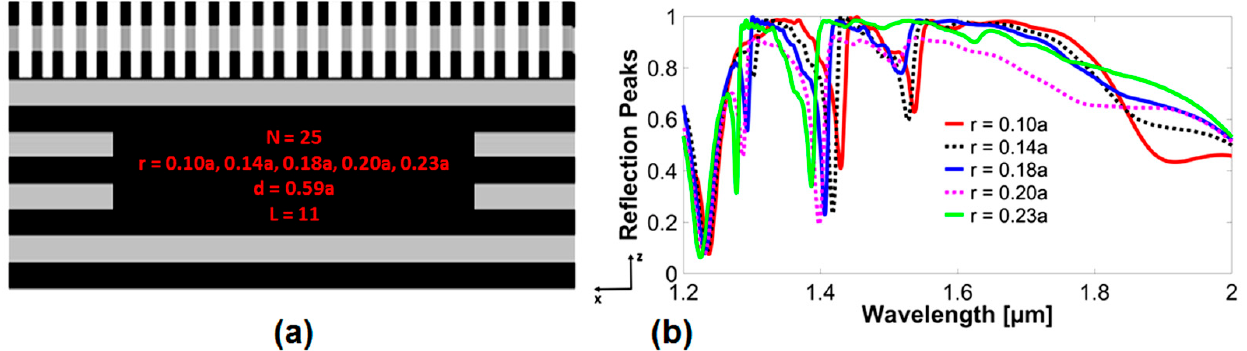
Figure 9. ( a ) Finite 2D-FDTD simulation models DBR-PhC structures with N = 25 and variation in value of hole radius. ( b ) Reflection spectra of the DBR-PhC structure with variation in the hole radius.